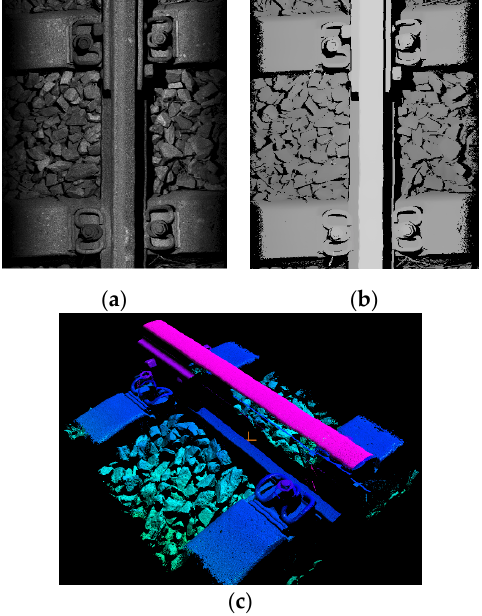
Figure 2. Nut looseness: ( a ) Intensity map; ( b ) depth map; ( c ) point cloud 3D reconstruction.